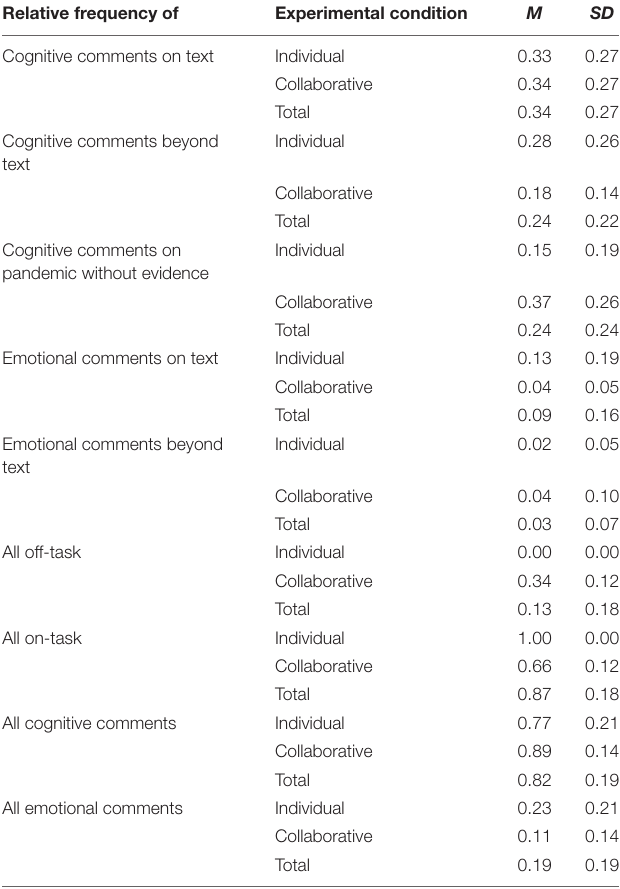
TABLE 5 | Descriptive statistics of the relative frequencies of cognitive and emotional reflection around the engagement with conflicting information and the pandemic in